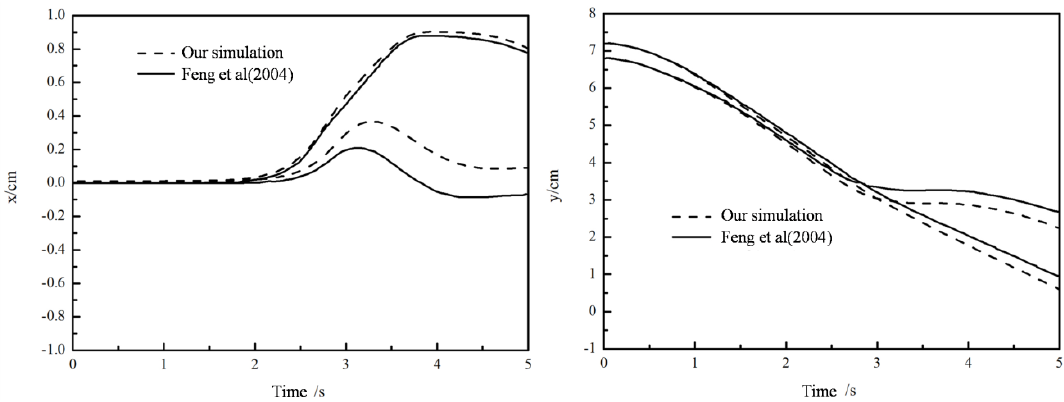
Figure 2. Coordinates of the two particles (left: x direction; right: y direction).